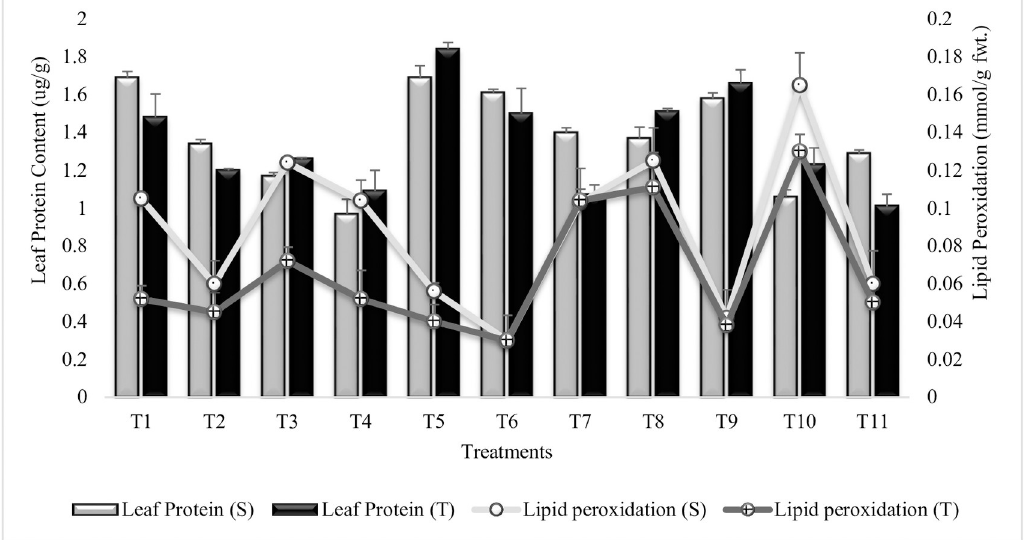
Fig 3. Leaf protein and lipid peroxidation contents of chickpea grown in sandy soil. Data are means of four replicates along with standard error bars (S-Sensitive Variety; T-Tolerant Variety).